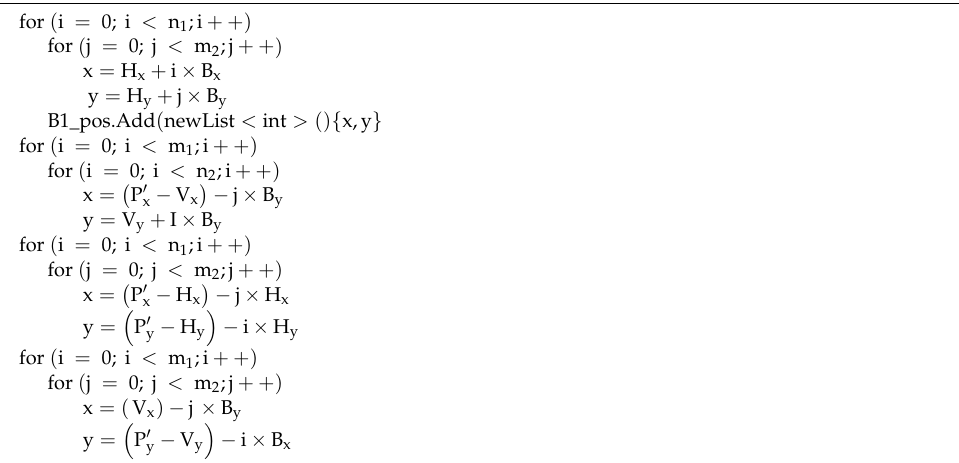
Algorithm 2. Non-overlapping coordinate